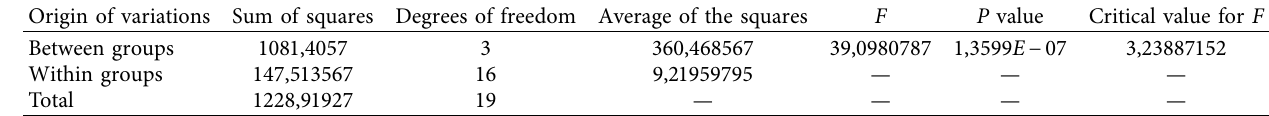
Table 8: ANOVA for the a280 instance.